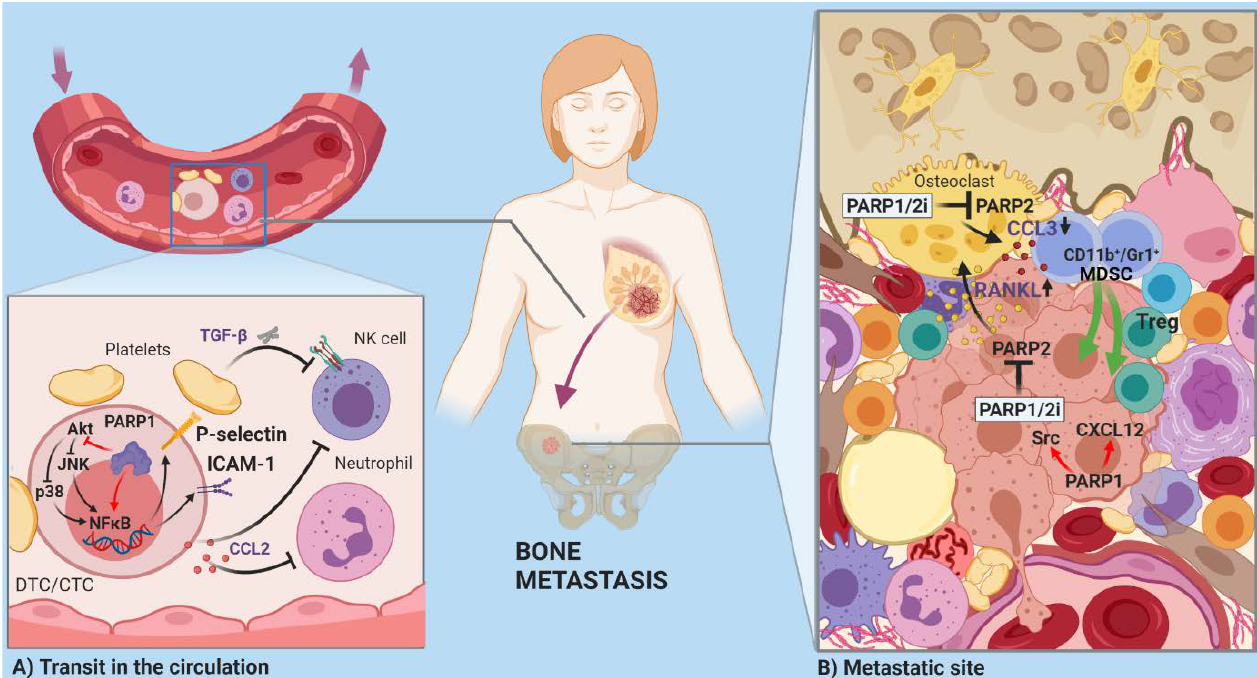
Figure 3. PARPs and metastasis. (A) In circulating disseminated tumor cells (DTCs), PARylation is involved in the downregulation of adhesion molecules (e.g., ICAM1, P-selectins), which establish contacts between tumor cells and platelets, offering protection from NK cells and granulocytes. PARP-1 is also instrumental in the expression of CCL2, a cytokine that educates granulocytes to not recognize DTCs. (B) DTCs lodged at metastatic sites must rely on cell death avoidance mechanisms to resist the hostile reactive stroma and attacks from innate immune cells (see also [12] and Figure 4). DTCs have a predilection for environments rich in survival factors characteristic of the primary tumor site. PARP-1 can reinforce Src signaling in the metastases of primary breast tumors, in which the Src pathway has been activated by estrogen. PARP-1 shuts down the CXCL12 promoter, which negatively affects the metastatic potential of CXCL12-dependent breast tumors in bone marrow. The complex interactions between tumor cells and stromal cells at a metastatic site can profoundly affect the outcome of chemotherapy. This is the case in BRCA1/2-negative breast cancer with a bone marrow metastasis, where the inhibition of PARP-1 is therapeutically beneficial, but the simultaneous inhibition of PARP-2 regulates CCL3 in osteoclasts, leading to colonization of the bone marrow, with immune-suppressive T cells facilitating the survival of the tumor cells.